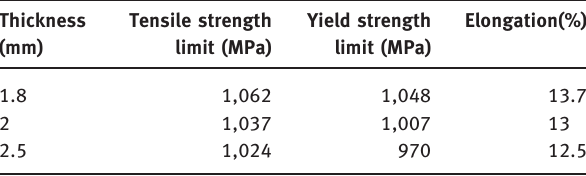
Table 1: Tensile properties of BM with different thicknesses.